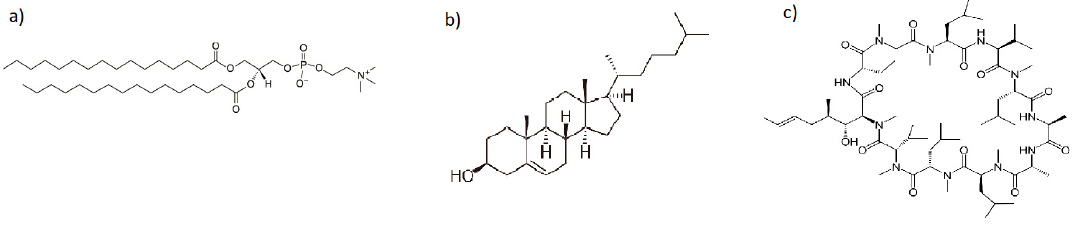
Figure 2. The structure of ( a ) DPPC,( b ) Chol,( c ) CsA.